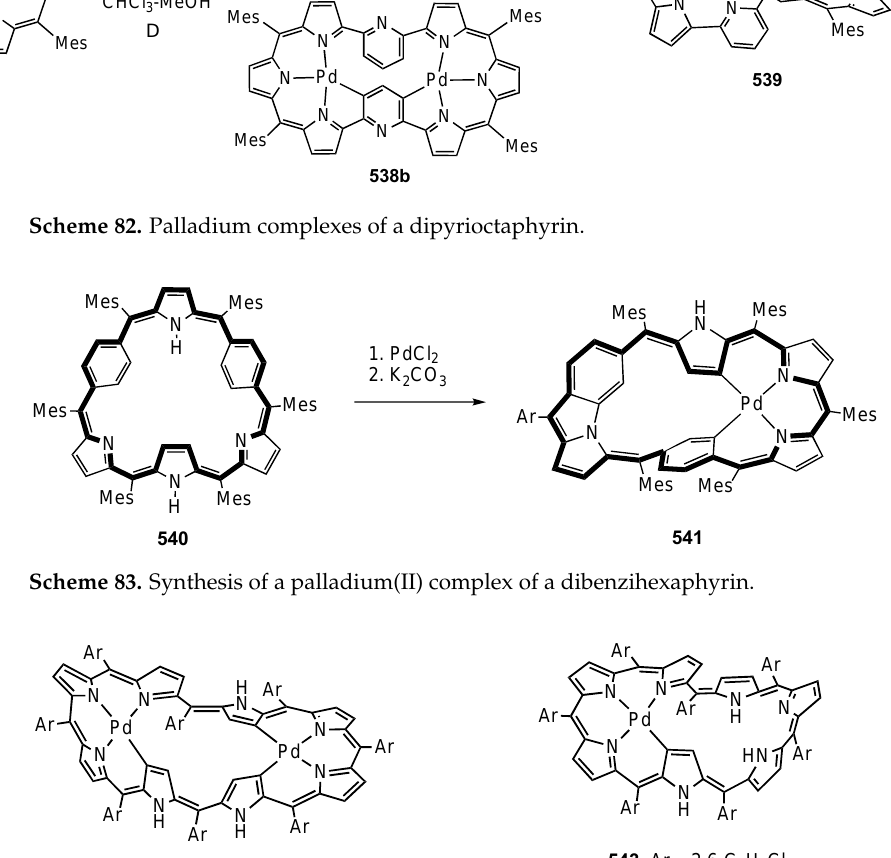
Figure 14. Möbius aromatic palladium(II) complexes of expanded porphyrins.